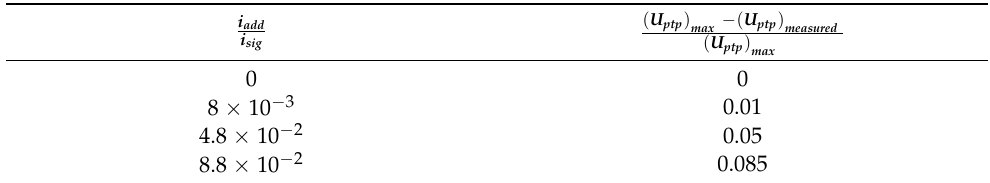
Table 1. Dependence of the peak-to-peak signal of the first harmonic U ptp on the relative contribution of the additive current i add